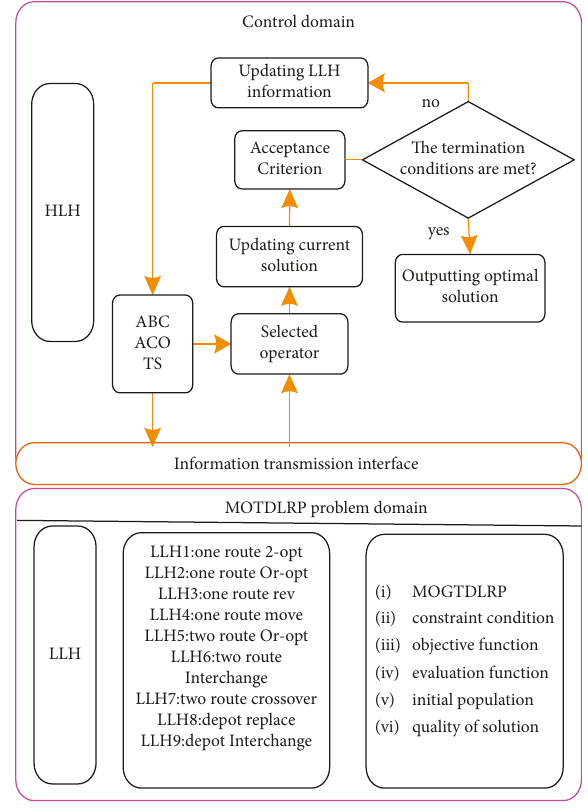
Figure 3: The flowchart of the